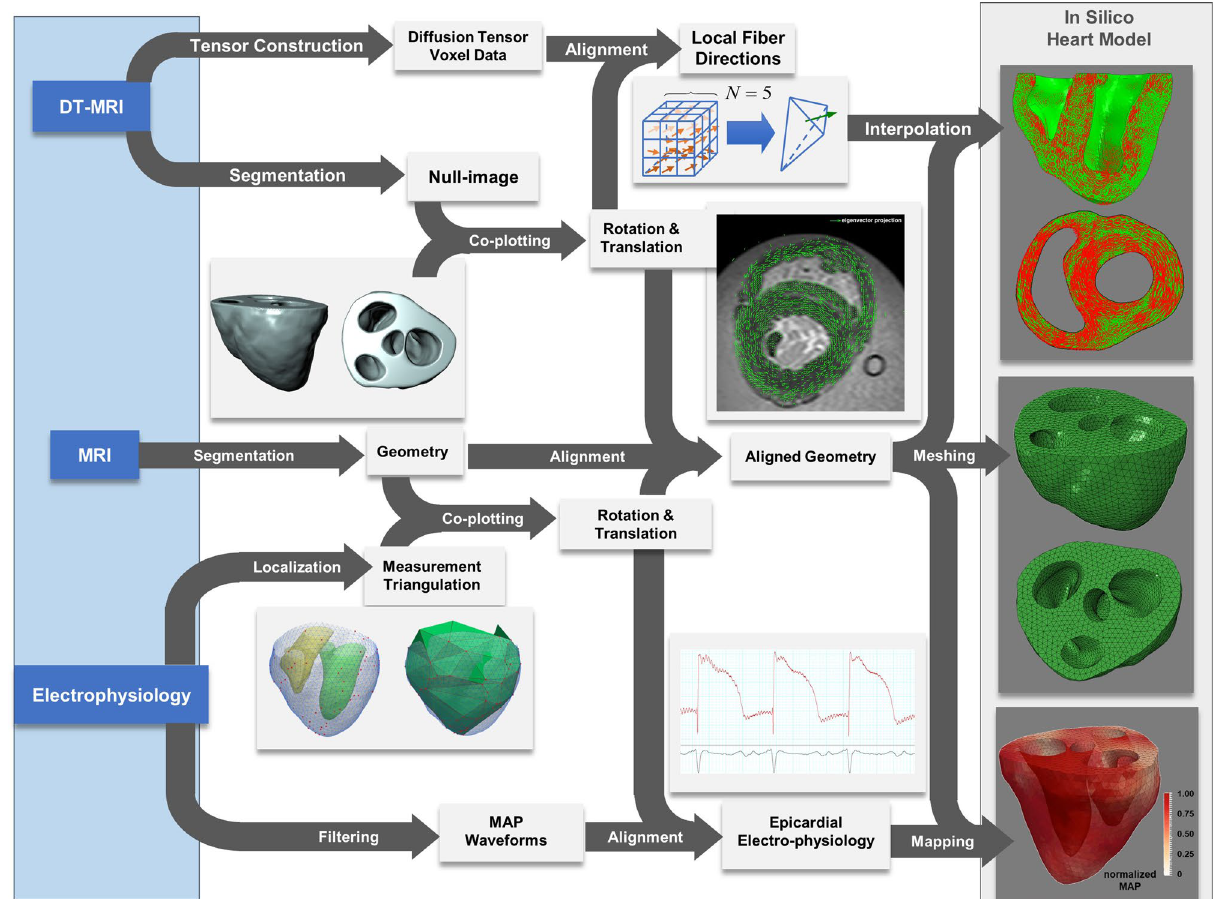
Figure 3. Extensive datasets collected from a single ovine heart (left light blue panel) were employed in a pipeline to develop the in silico heart model. MRI, DTMRI, and temporal evolutions of MAPs were co-localized in a 4D FE